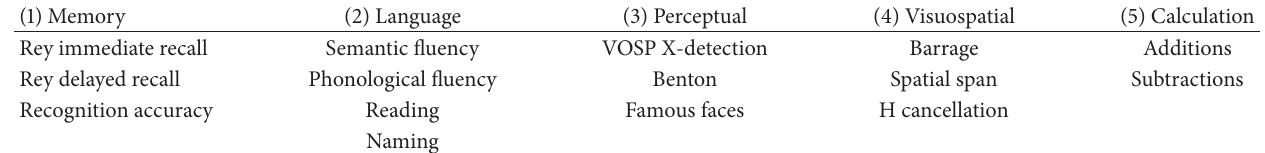
Table 3: Factors extracted from the principal component analysis and variables that loaded into the factors.